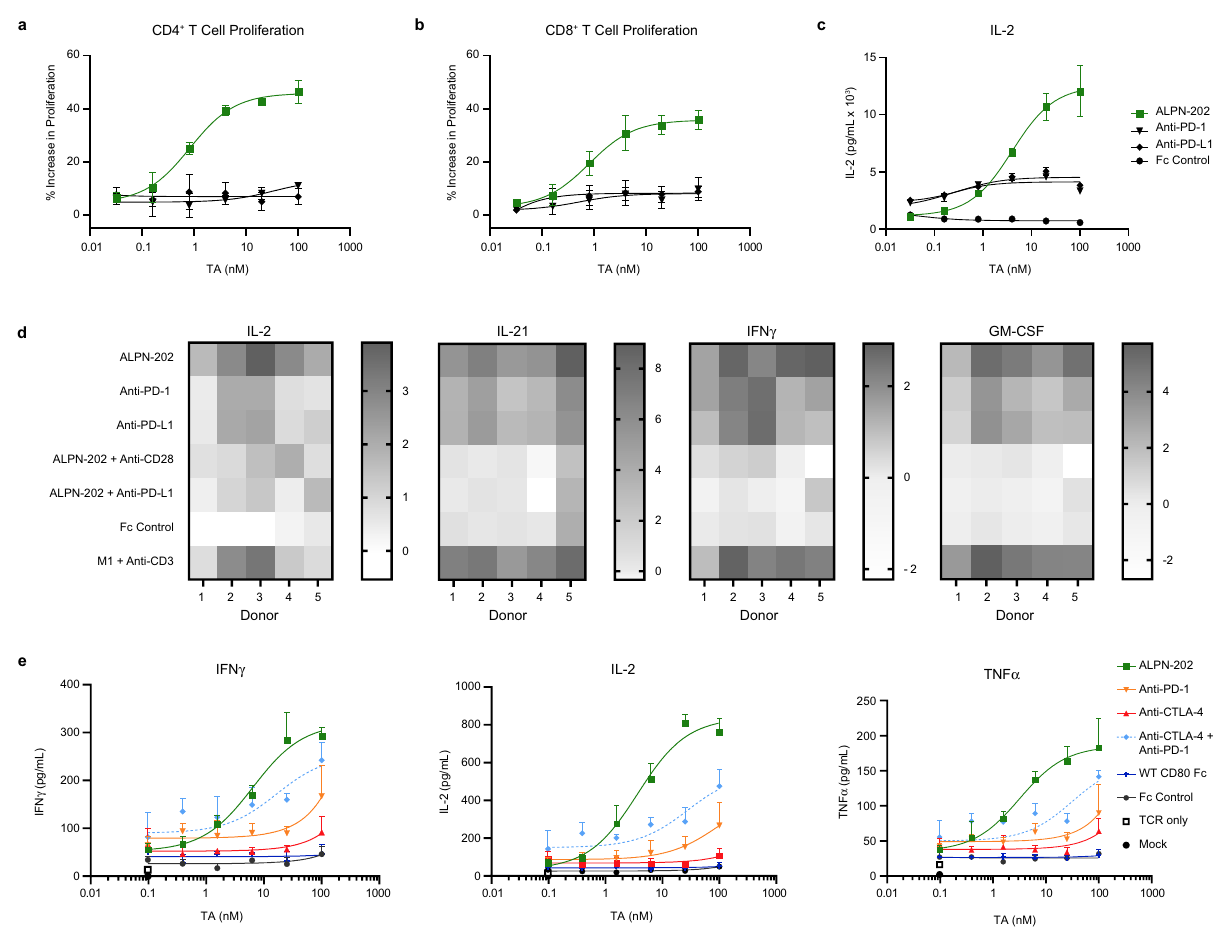
Fig. 4 ALPN-202 increases T cell activation more potently than CPI alone in the presence of PD-L1 + suppressive M2c macrophages. Primary human T cells were co-cultured with in vitro-derived M2c macrophages and a titration of ALPN-202 or anti-PD-1, PD-L1, or CTLA-4 blocking antibodies. ALPN- 202 induced ( a ) CD4 + T cell proliferation, ( b ) CD8 + T cell proliferation, and ( c ) IL-2 secretion in a dose-dependent manner more potently than CPI alone. Proliferation data shown are mean percent increase relative to Fc control and is from a representative donor ( n = 5 donors). Error bars are SD from triplicate wells. TA test article. d ALPN-202 activity increased expression of IL-2, IL-21, IFN γ , and GM-CSF in cell culture supernatants and is dependent on binding to PD-L1 and CD28. Data are shown as fold-increase (dark shade) or decrease (white) with respect to untreated control (M2c + anti-CD3). Data shown are from fi ve donors and were collected in two independent experiments. M1 proin fl ammatory M1 macrophages. e To compare ALPN-202 activity to PD-1, CTLA-4, or dual checkpoint inhibition (CPI), E6 TCR + T cells were co-cultured with M2c macrophage and SCC152/hPD-L1 + tumor cells for 24 h. Mean ± SD for IFN γ , IL-2, and TNF α was quantitated from triplicate wells. Data are representative of four donors tested in two independent